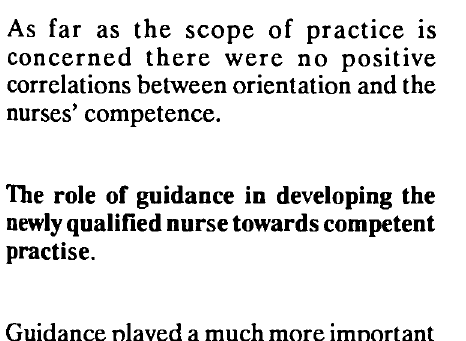
Table 2 Comparison of the evaluation of the newly qualified nurse to communicate with patients and their